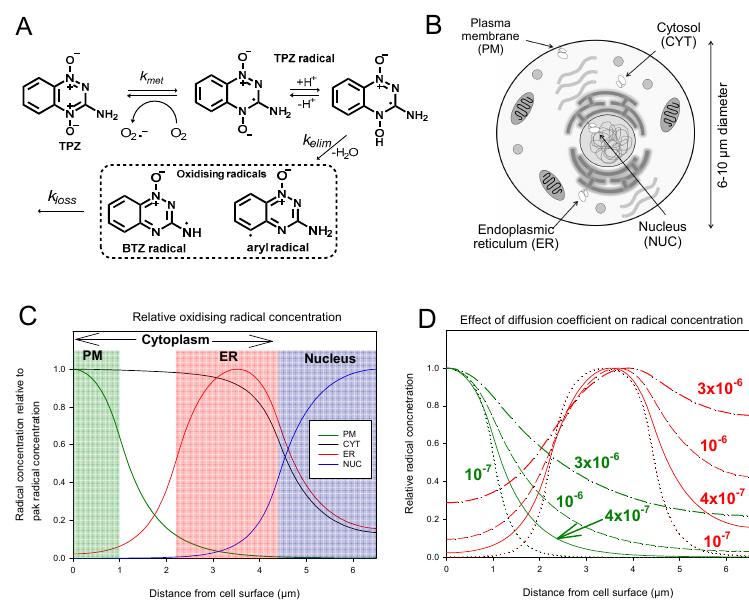
Figure 1. Reaction-diffusion modelling predicts non-isotropic distribution of cytotoxic TPZ radicals following TPZ activation under anoxia in sub-cellular compartments: ( A ) Scheme showing the metabolic activation of TPZ, which undergoes one-electron reduction to generate the oxygen-sensitive radical anion. The protonated radical eliminates water to generate reactive oxidizing benzotriazinyl (BTZ) and aryl radicals, in the absence of oxygen; ( B ) Schematic representation showing sources of one-electron TPZ reduction explored in the present study; ( C ) Reaction-diffusion modelling of the intracellular steady state TPZ-derived oxidizing radicals (relative to peak concentration) when generated in di ff erent subcellular compartments (PM green, ER red, CYT black, NUC blue), assuming an intracellular di ff usion coefficient, D , of 4 × 10 − 7 cm 2 s − 1 for TPZ and its radicals; ( D ) Model results for D = 10 − 7 cm 2 s − 1 (dotted line), 4 × 10 − 7 cm 2 s − 1 (solid line), 10 − 6 cm 2 s − 1 (dashed line) or, 3 × 10 − 6 cm 2 s − 1 (dot-dash line) for activation at the PM (green) or ER (red).